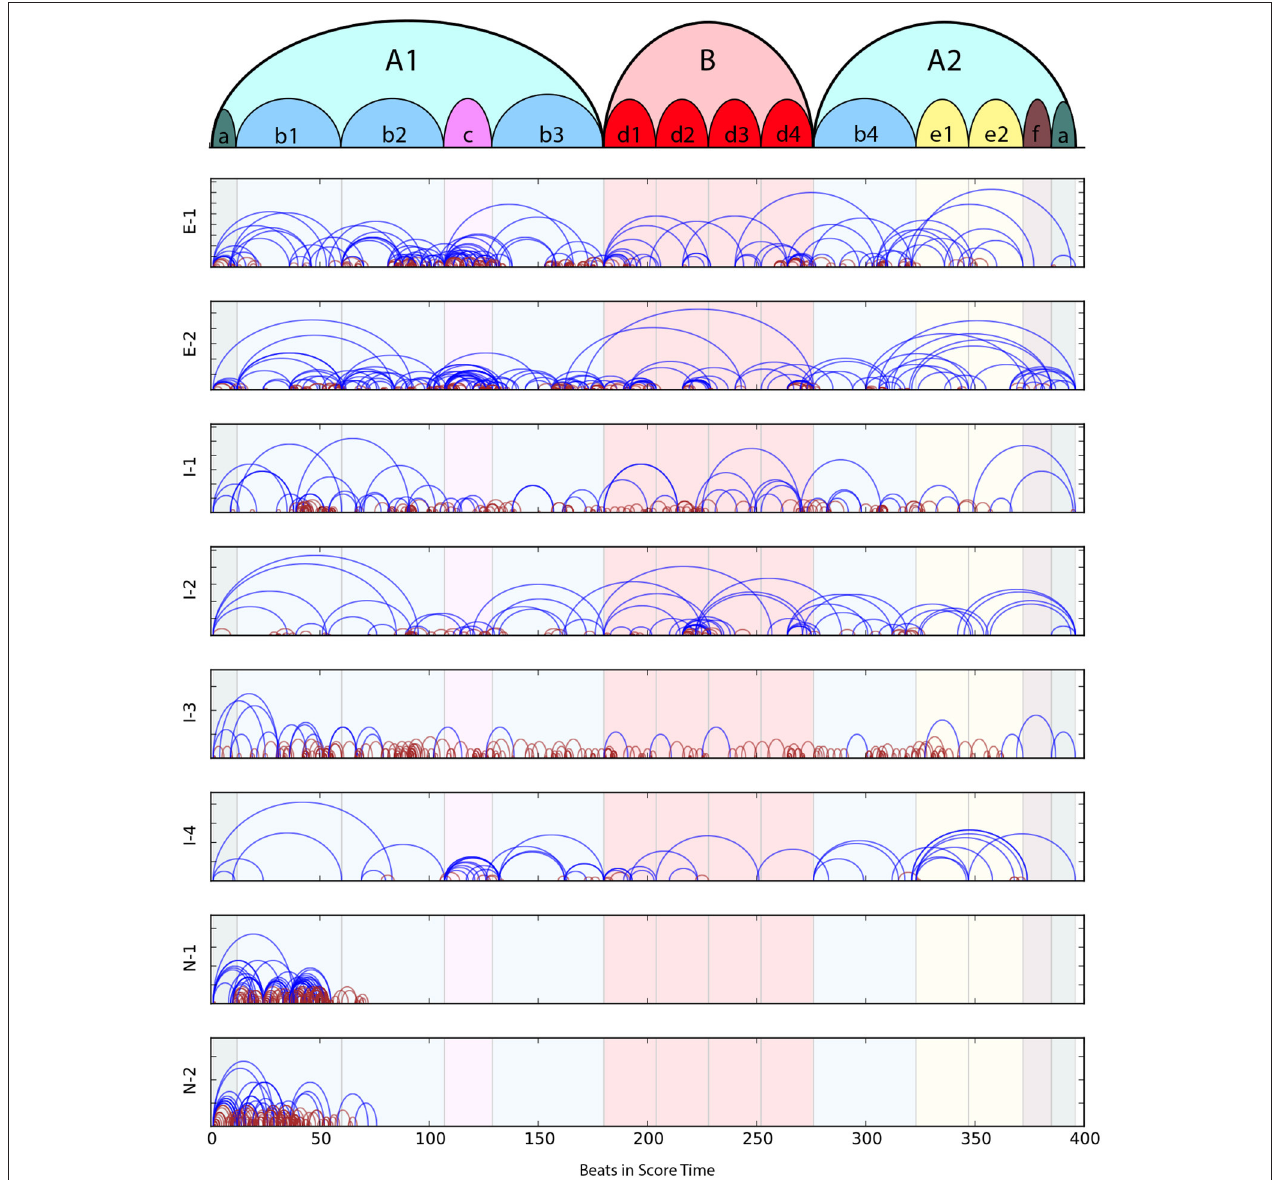
FIGURE 9 | Practice Segment Arcs for each participant. The top-most diagram shows the sectional structure of Chopin’s “Mazurka in A minor Op. 17 No. 4.” In subsequent graphs, blue lines mark Drill-Smooth segments and dark red lines are Drill-Correct segments; background panels delineate the formal structure of the